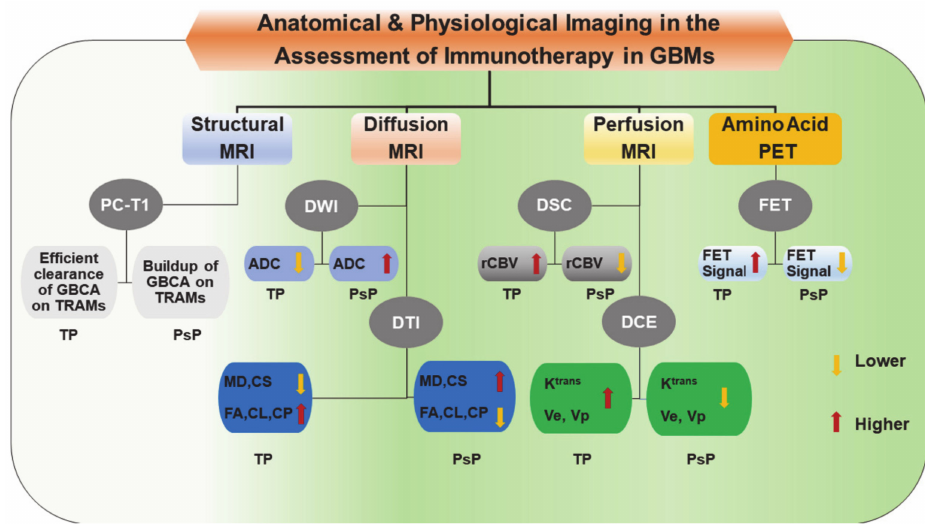
Figure 5. A block diagram is showing trends in structural, and physiologic imaging parameters that are usually observed in distinguishing true progression (TP) from pseudoprogression (PsP) in GBMs following treatment with immunotherapy. ADC, Apparent diffusion coefficient; CL, Coefficient of linear anisotropy; CP, Coefficient of planar anisotropy; CS, Coefficient of spherical anisotropy; DCE, Dynamic contrast-enhanced; DSC, Dynamic susceptibility contrast; DTI, Diffusion tensor imaging; DWI, Diffusion weighted imaging; FA, Fractional anisotropy; FET, O-(2-[ 18 F] fluoroethyl)-L-tyrosine; GBCA, gadolinium-based contrast agent; GBM, Glioblastoma; K trans , Volume transfer constant; MD, Mean diffusivity; MRI, Magnetic resonance imaging; PC-T1; Post-contrast T1 weighted images; PET, Positron emission tomography; PsP, Pseudo- progression; rCBV, relative cerebral blood volume; TP, True Progression; TRAM, Treatment response assessment map; Ve, Fraction of extracellular-extravascular space; Vp, Fraction of plasma